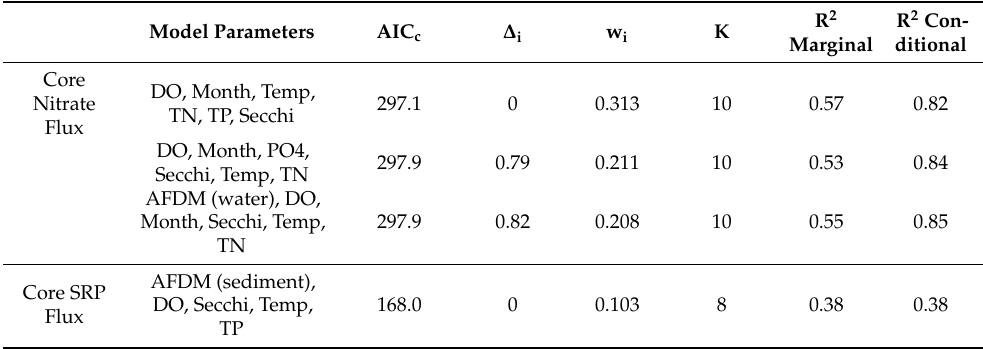
Table 2. Linear mixed model regression results of nitrate and soluble reactive phosphorus (SRP) flux rates vs. integrated water chemistry in Roundaway Lake, MS.